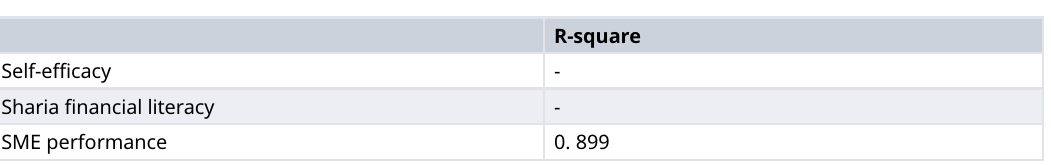
Table 1. R-square results.